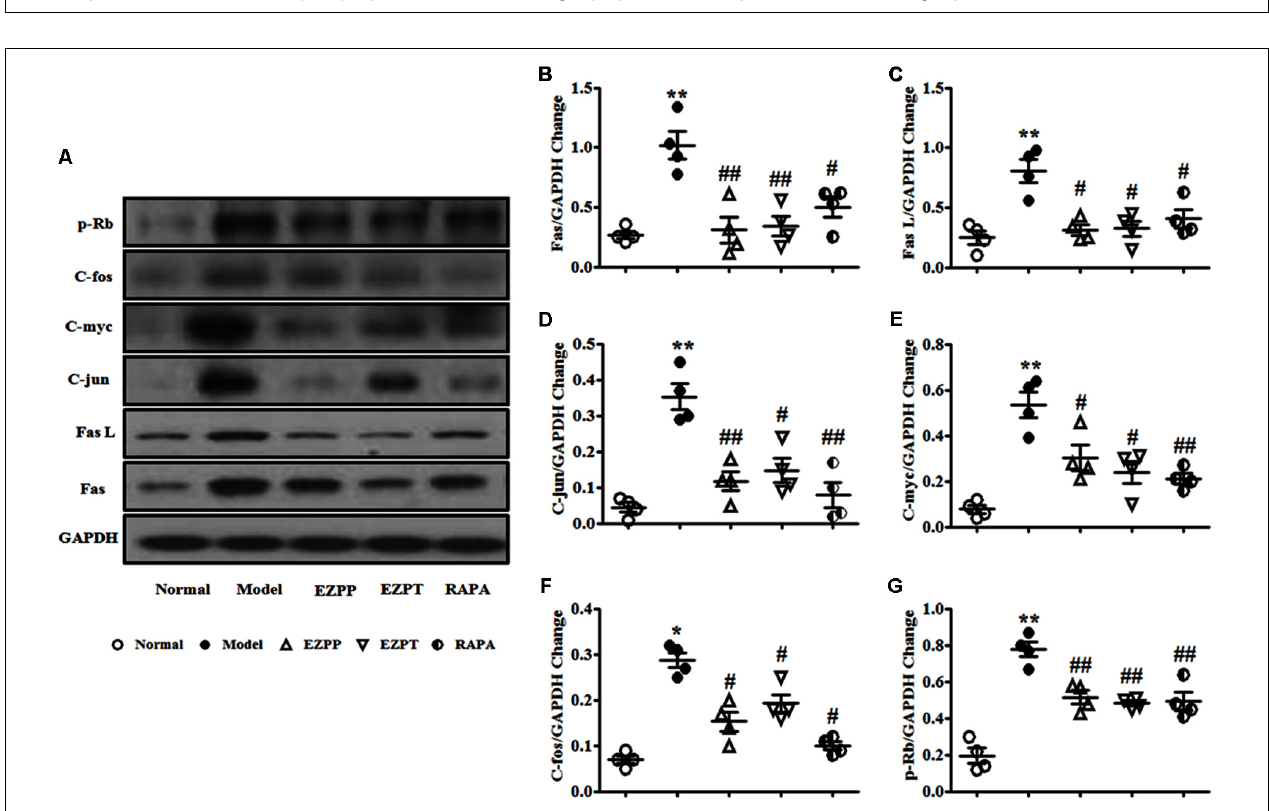
FIGURE 8 | Western blotting of Fas, Fas L, C-jun, C-myc, C-fos, and p-Rb. (A) Western blotting of Fas, Fas L, C-jun, C-myc, C-fos, and p-Rb. (B) Quantitative analysis of Fas. (C) Quantitative analysis of Fas L. (D) Quantitative analysis of C-jun. (E) Quantitative analysis of C-myc. (F) Quantitative analysis of C-fos. (G) Quantitative analysis of p-Rb. Data are presented as mean ± SEM ( n = 3). ∗ p < 0.05 and ∗∗ p < 0.01 versus Normal group; # p < 0.05 and ## p < 0.01 versus Model group.